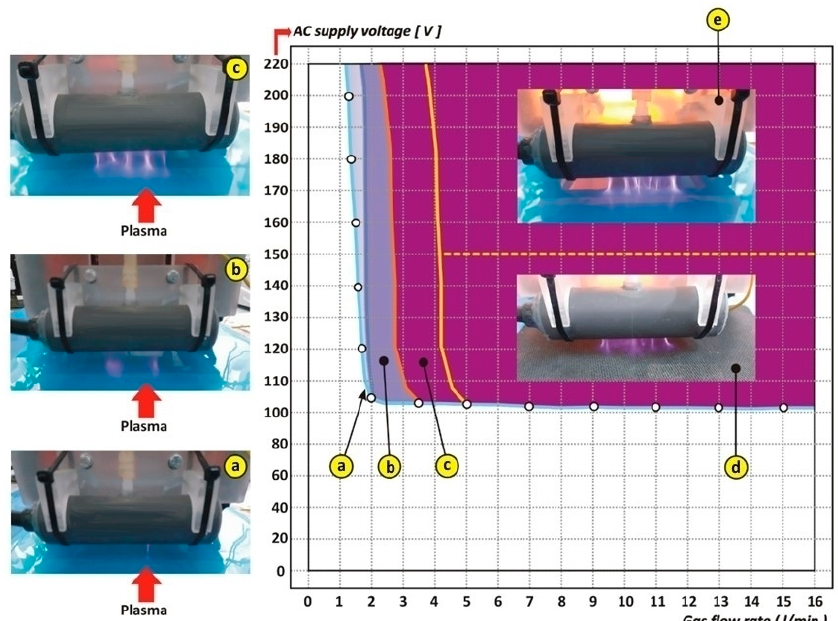
Figure 3. Plasma operational stability diagram for the plasma generated with our 50 mm wide cold plasma applicator head. This diagram shows four regions corresponding to the parameters which describe the different evolution stages of our plasma discharge: ( a ) No plasma; ( b ) Filamentary initial discharge; ( c ) Developing stage plasma; ( d ) Fully developed plasma.